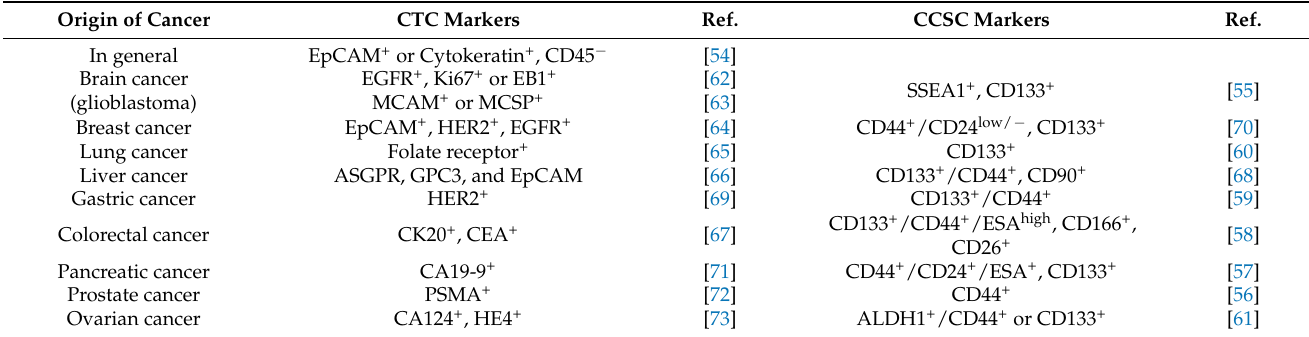
Table 2. Common cell surface markers to identify CTCs and